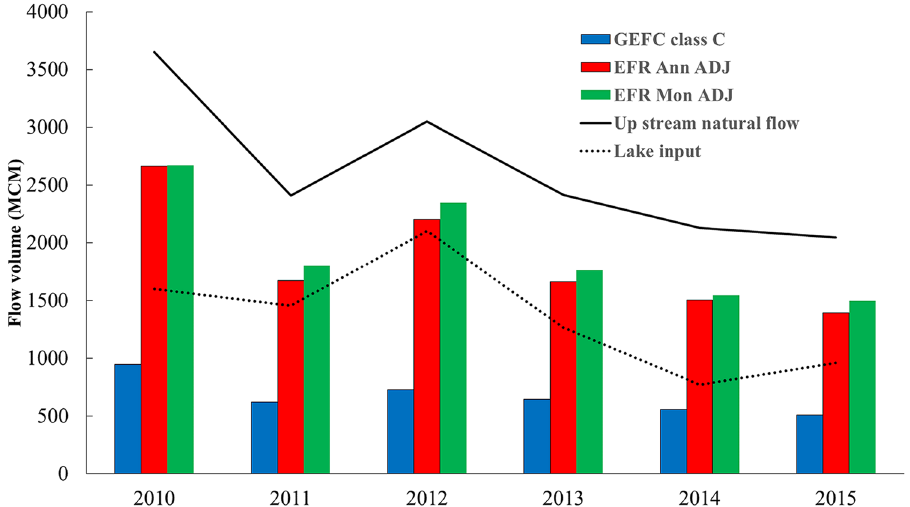
Figure 10. Comparison of environmental flow allocation from two new annual and monthly methods with the conventional GEFC method and with natural river flow capacity and water entering from 10 main rivers to the lake in